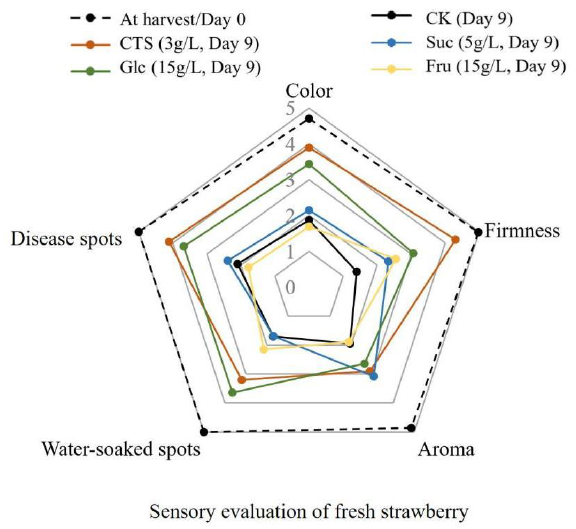
Figure 5. Sensory evaluation of fresh strawberry fruits at the 0th day and strawberry fruits treated with 3 g/L chitosan, 5 g/L sucrose, 15 g/L glucose, and 15 g/L fructose, respectively, at the 9th day, stored at 15 ± 2 °C. CK represents that strawberry fruits were immersed with water before storage. The information about sensory indicator and standard for evaluation can be found in supplemen- tary table S1. Data are mean of scores given by twenty panelists. CTS, chitosan; Suc, sucrose; Glc, glucose; Fru,